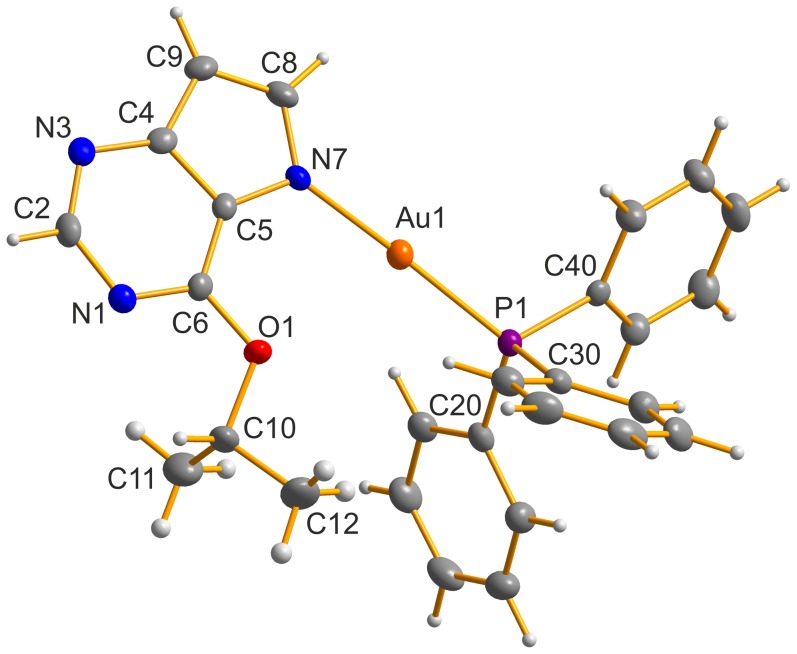
The molecular structure of [Au(L2)(PPh3)] (2), showing the atom numbering scheme.Non-hydrogen atoms are displayed as ellipsoids at the 50% probability level.